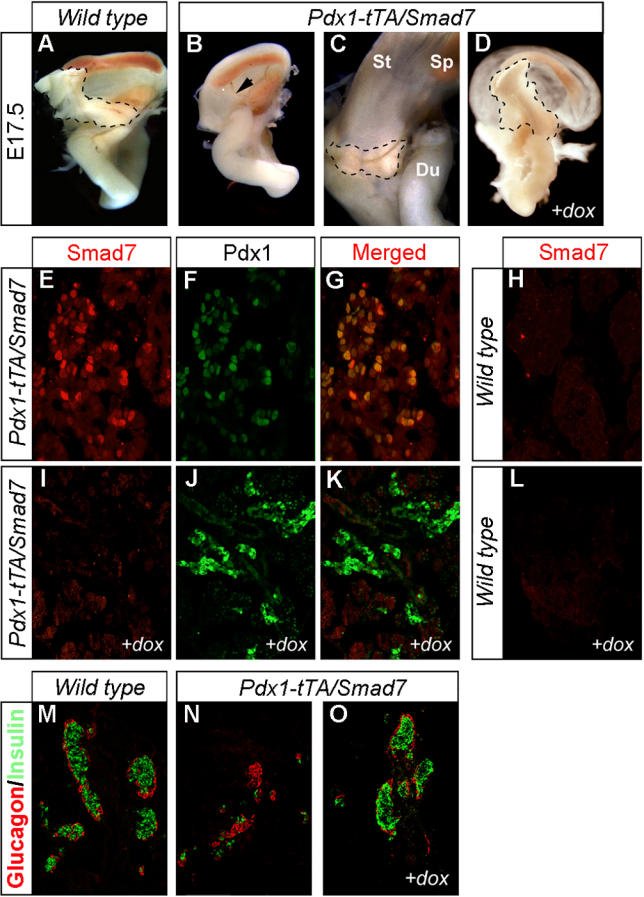
Conditional Smad7 Expression in Embryonic Pdx1
+ Cells Leads to Pancreatic Malformation
(A–D) Whole-mounted abdominal organs from E17.5 embryos with the indicated genotypes.(A–C) Views of the pancreas (outlined by dashes) at E17.5 in wild-type and bitransgenic
Pdx1-tTA/Smad7 mice. (C) shows a magnified view of the pancreatic region marked by the arrow in (B). Adjacent organs marked in (C): St, stomach; Sp, spleen; Du, duodenum.
(D) Bitransgenic
Pdx1-tTA/Smad7 embryos from doxycycline-fed mothers (+
dox) develop a morphologically normal pancreas.
(E–L) Smad7 (red) or Pdx1 (green) expression detected by immunohistochemistry in the pancreas of E14.5 mice with the indicated genotypes.(M–O) Immunohistochemical detection of glucagon
+ (red) and insulin
+ (green) cells at P1 in mice with the indicated genotypes.
(O) Bitransgenic
Pdx1-tTA/Smad7 embryos from doxycycline-fed mothers (+
dox) develop normal-appearing islets. Original magnification is 4× for (A–D), 63× for (E–H), and 20× for (I–O).